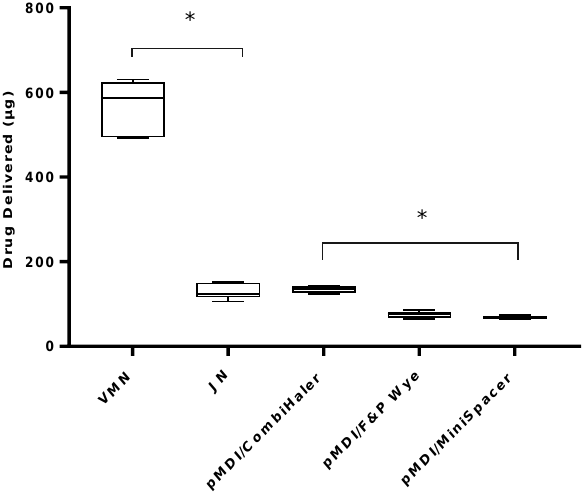
Figure 6. Aerosol drug delivery using LTV ventilation during simulated mechanical ventilation with active humidification. Three different devices, VMN, JN, and pMDI, using three different spacer/adapter types, were tested. pMDI actuation was at the start of inhalation. Results are presented as mean ± SD µg drug delivered. * Denotes statistical significance at p < 0.0001. Table 3. Residual drug post nebulisation within the VMN and JN devices and the pMDI adapters during active and passive humidification (STD = standard). Results are presented as mean ± SD % residual